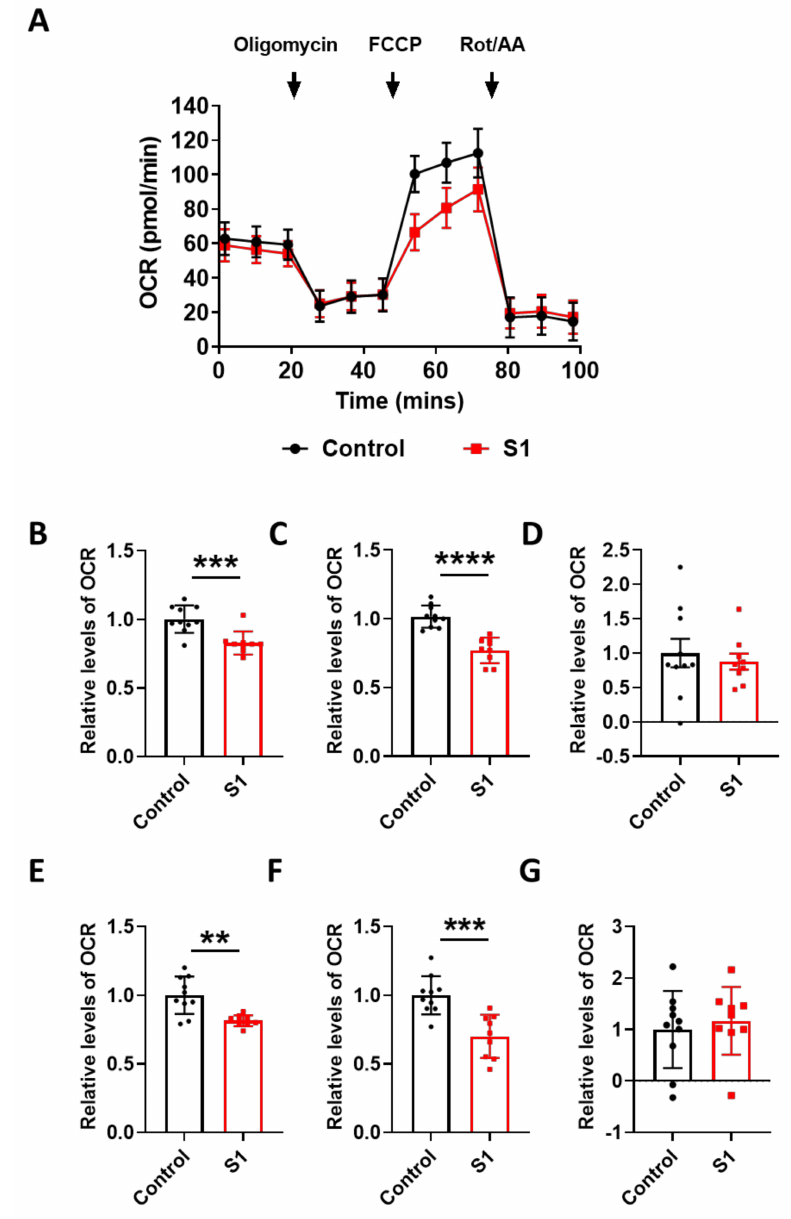
Figure 5. S1 domain spike protein reduces overall mitochondrial respiration of the human brain ECs. ( A ) Mito stress test was performed with the treatment of S1 (15 nM), followed by injection: 2.5 µ M oligomycin; 2 µ M FCCP; 0.5 µ M Rotenone/Antimycin. ( B – G ) Parameters are calculated by